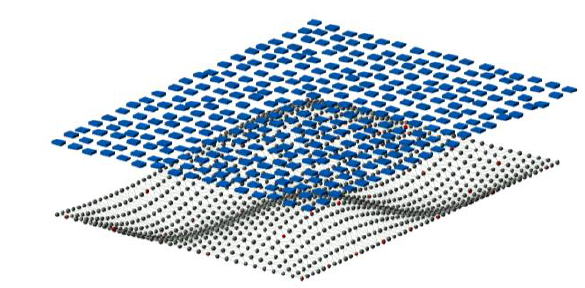
Figure 7. Overview on simulated flight order with 80/80 image overlap